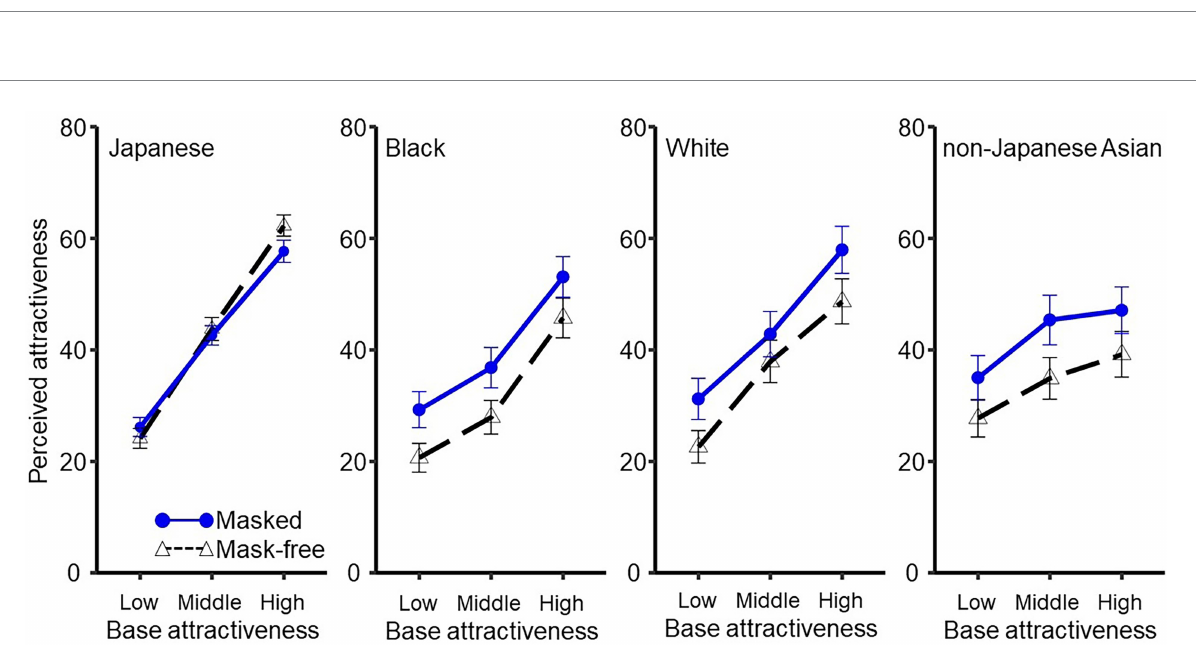
FIGURE 3 Attractiveness rating scores for masked and mask-free faces in each experiment. From left to right: Japanese, Black, White, non-Japanese Asian. Error bars represent standard